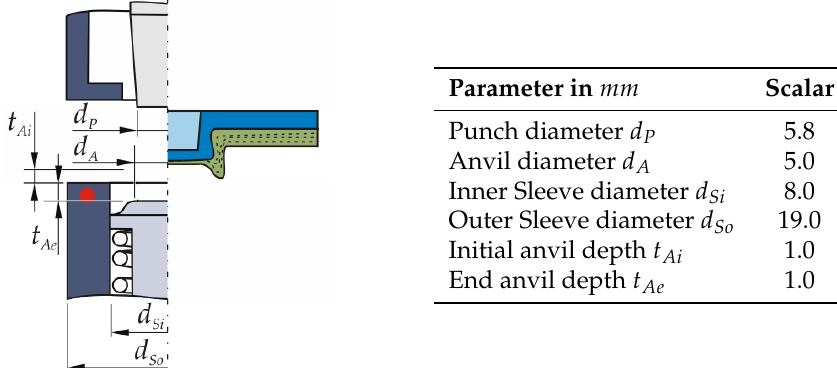
Figure 7. Schematic illustration of Hotclinching tools with parameters. Insert